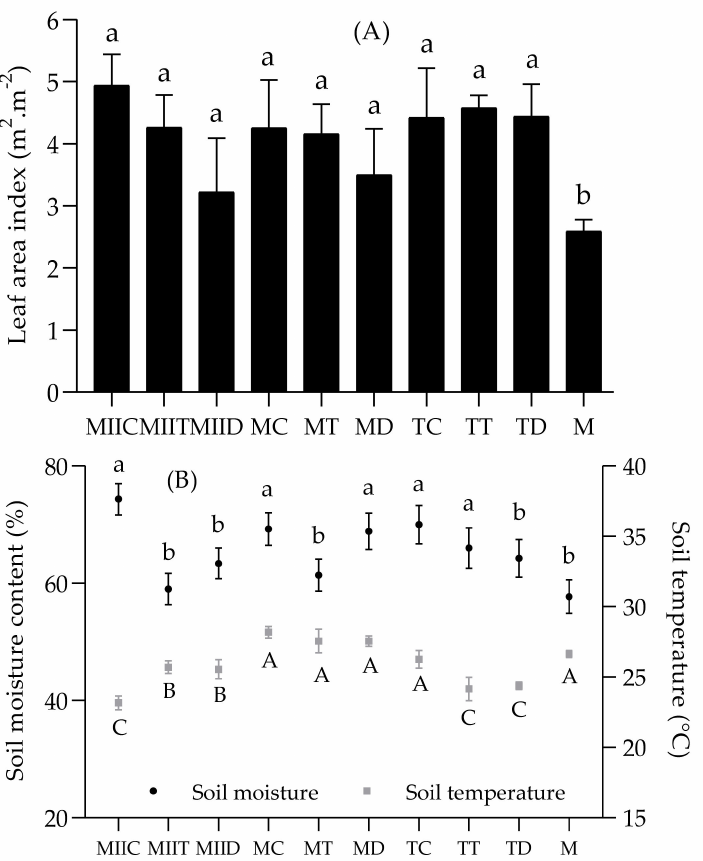
Figure 7. Comparison of Leaf Area Index ( A ) and soil moisture and temperature ( B ) in Push–Pull systems. Different letters indicate a significant difference by the Scott–Knott test ( α = 0.05). For abbreviations, see Table